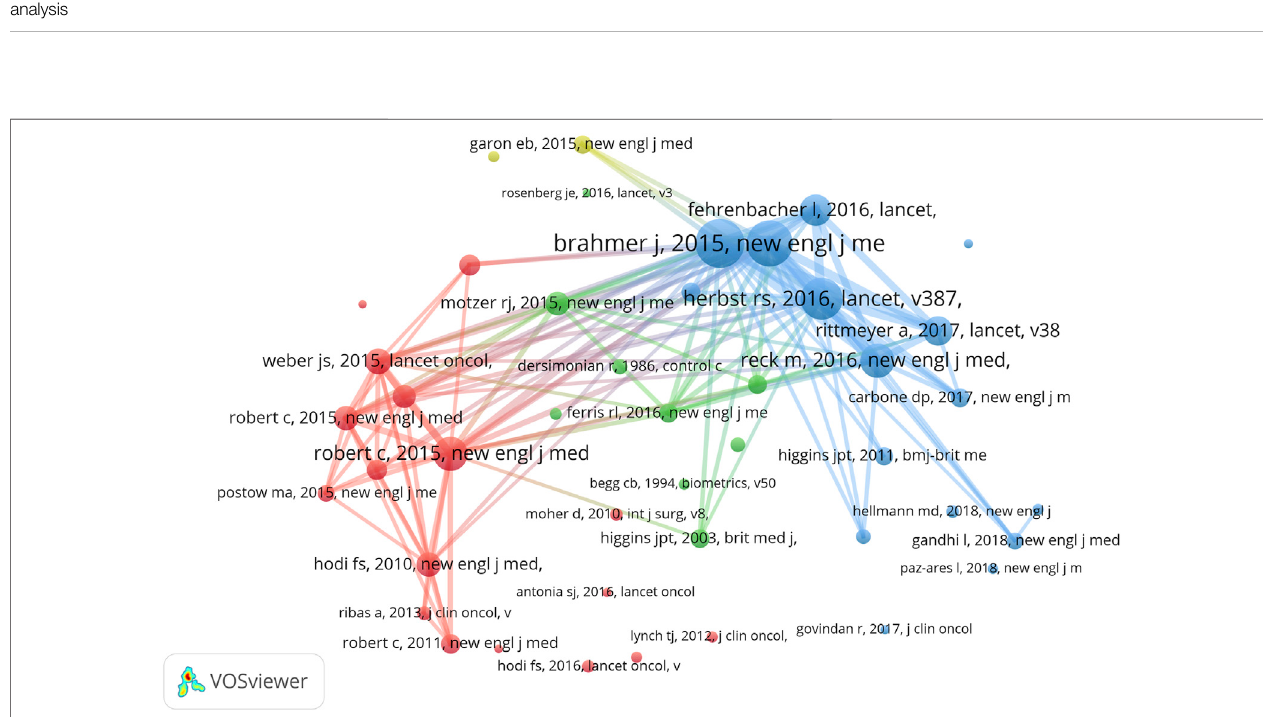
FIGURE 4 | VOSviewer network visualization map of co-citation analysis in meta-analysis of anti-PD1/PDL1.